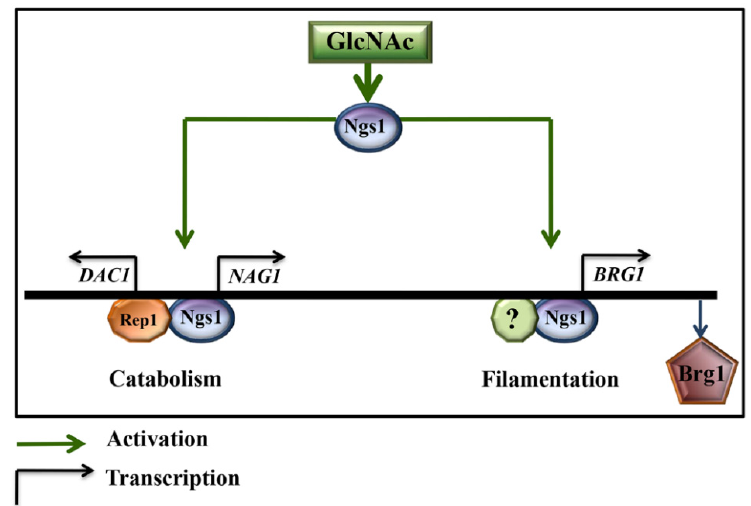
Figure 3. N-acetylglucosamine (GlcNAc) stimulates signaling via GlcNAc sensor and transducer Ngs1. Upon GlcNAc binding, Ngs1 induces expression of GlcNAc catabolic genes (e.g., NAG1 and DAC1 ) [34] and filamentation regulating transcription factor, BRG1 by acetylating at their promoters [14]. Transcription factor (TF) Rep1 recruits Ngs1 to the GlcNAc catabolic gene promoters (left panel), whereas TFs recruiting Ngs1 to BRG1 promoter are yet to be found (right panel). The active relationship is represented with green lines and transcriptional promotion is represented with black arrows.